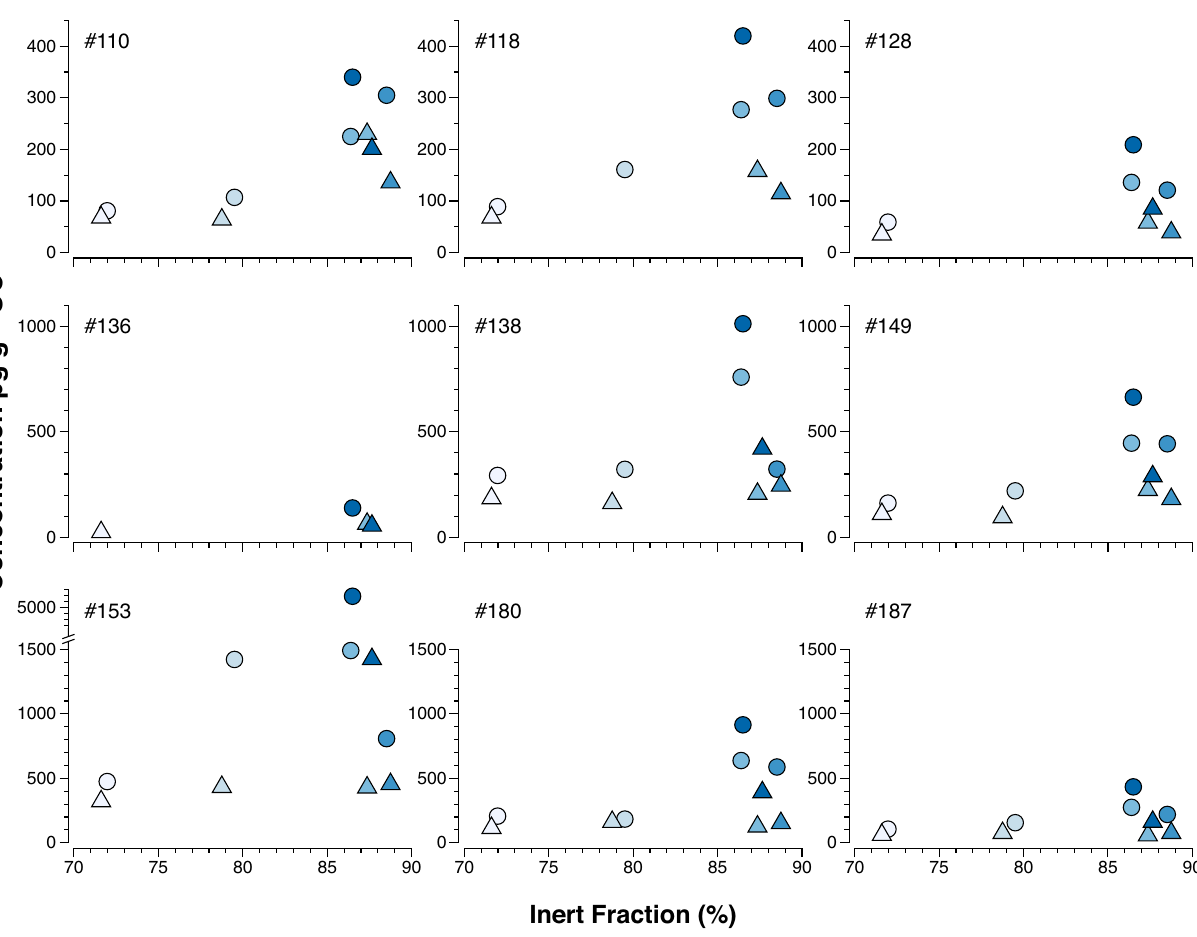
Fig.5|Concentrationsofninepolychlorinatedbiphenyl(PCB)congenersinpg g − 1 organic carbon (OC) in Atacama sediment (upper 40mm) versus the inert fraction (%; non-generative organic carbon fraction/total organic carbon;